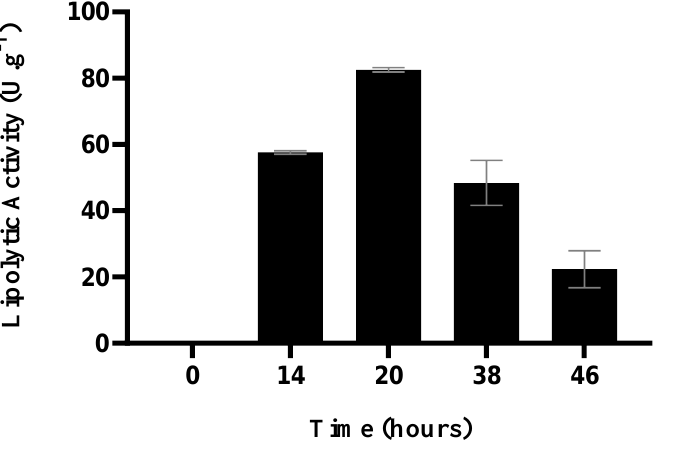
Figure 4. Supplementation of the fermentation matrix with soybean oil (1.5% w / v ) and Tween 80 0.001 (% w / v ).